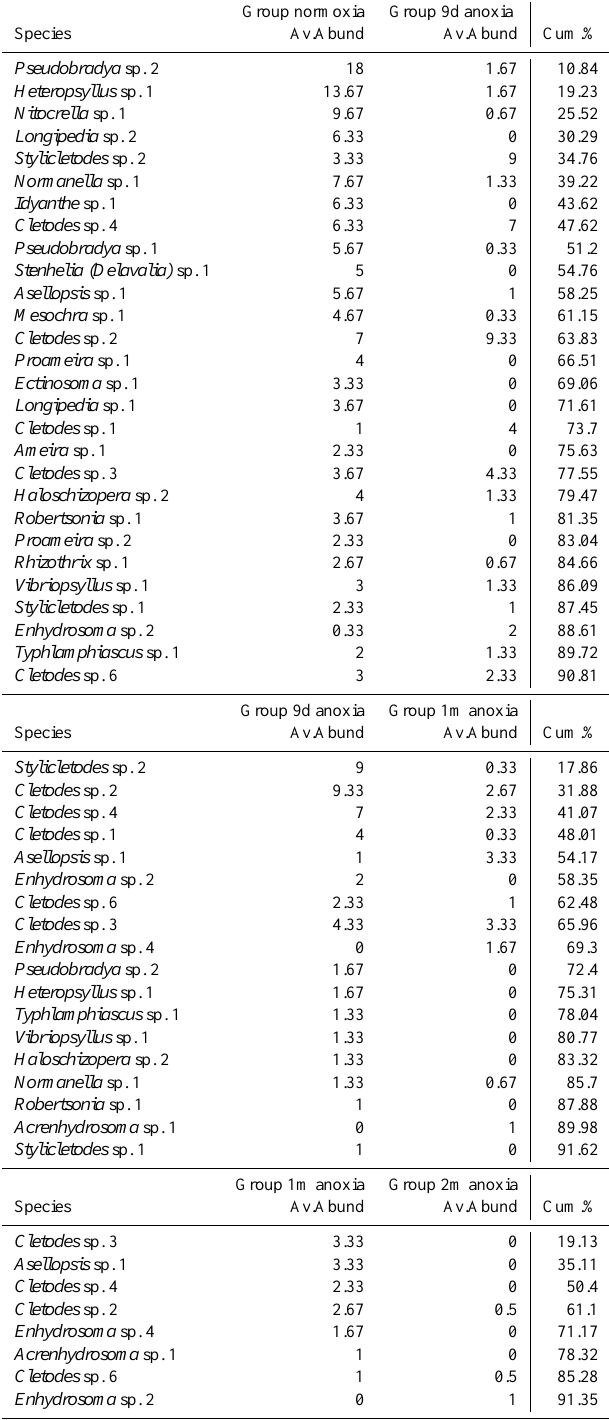
Table 1. SIMPER analysis – average abundances of species within a group (treatment) and cumulative contribution to dissimilarity. N = normoxia, A = anoxia, duration of treatment: 9days, 1month, 2months.